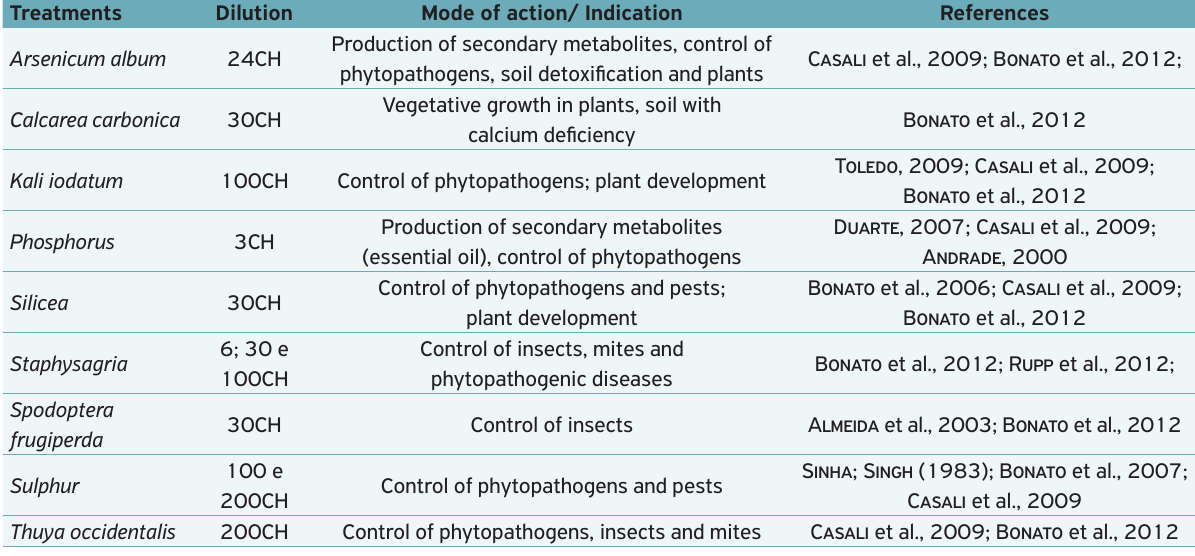
Table 1. Homeopathic medicines used with respective dilutions, mode of action and indications from the literature.